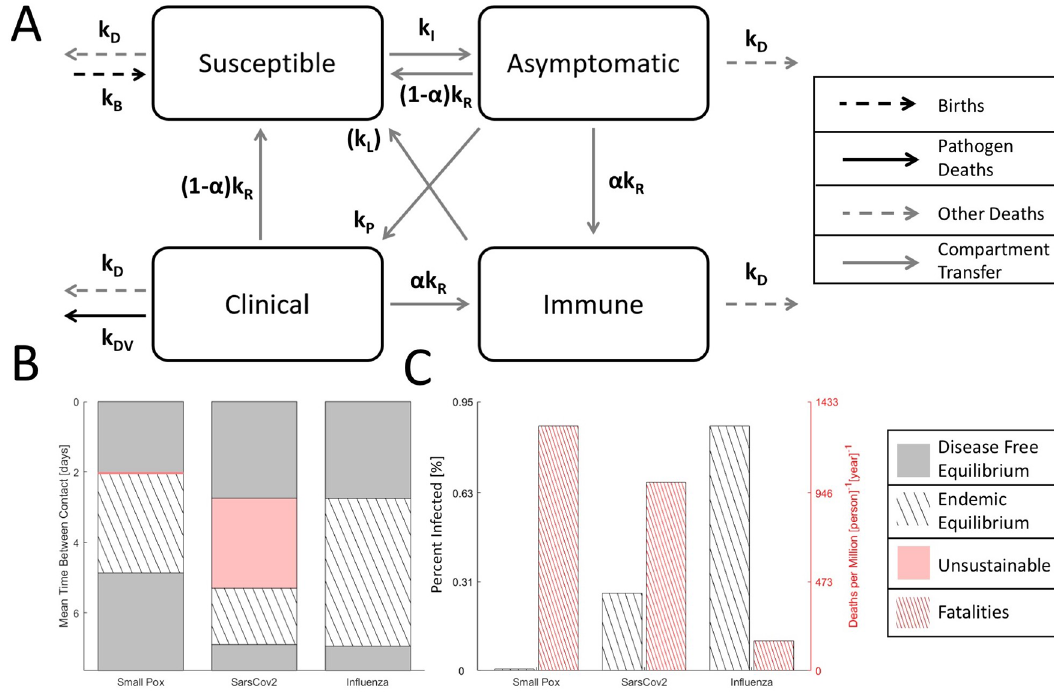
Figure2.Fourcompartmentmodelofanepidemic. A.Cartoonofthecompartmentmodel.Notethat,inthemodel, permanent immunity is gained with probability α for mathematical convenience. Alternatively, temporary immunity can be gained with a probability of 1 and lost at rate k L . Although the dynamics are different, the corresponding endemic equilibria can be identified by expressing k L as function of α and compartment frequencies. B. Disease free equilibrium (gray), endemic equilibrium (striped), and unsustainable (red) regions for three analyzed viruses over a rangeofhostcontactrates.Theunsustainableregionforsmallpox-likevirusesisnarrowandnotshowntoscale.C.For endemic equilibrium (contact rates correspond to the midrange shown in B), the fraction of the host population infected and the death rate. Note that, representing equilibrium, the choice of timescale (years) is